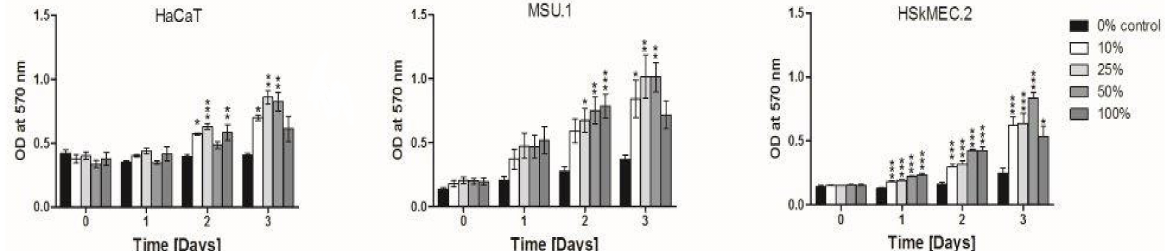
Figure 12. The influence of the HATMSC1 supernatant on the proliferation of cells involved in wound healing (keratinocytes HaCaT, fibroblasts MSU-1.1 and skin endothelial cells HSkMEC.2). Target cell proliferation was evaluated using an MTT test and expressed by OD value at 570 nm after culture for 3 days in the serum free DMEM medium (0% control) and in the presence of diluted (10–50%) and non-diluted (100%) HATMSC1 cell line supernatant. Data represents mean ± SEM, * p < 0.05, ** p < 0.01, *** p < 0.001 from 3 independent experiments.